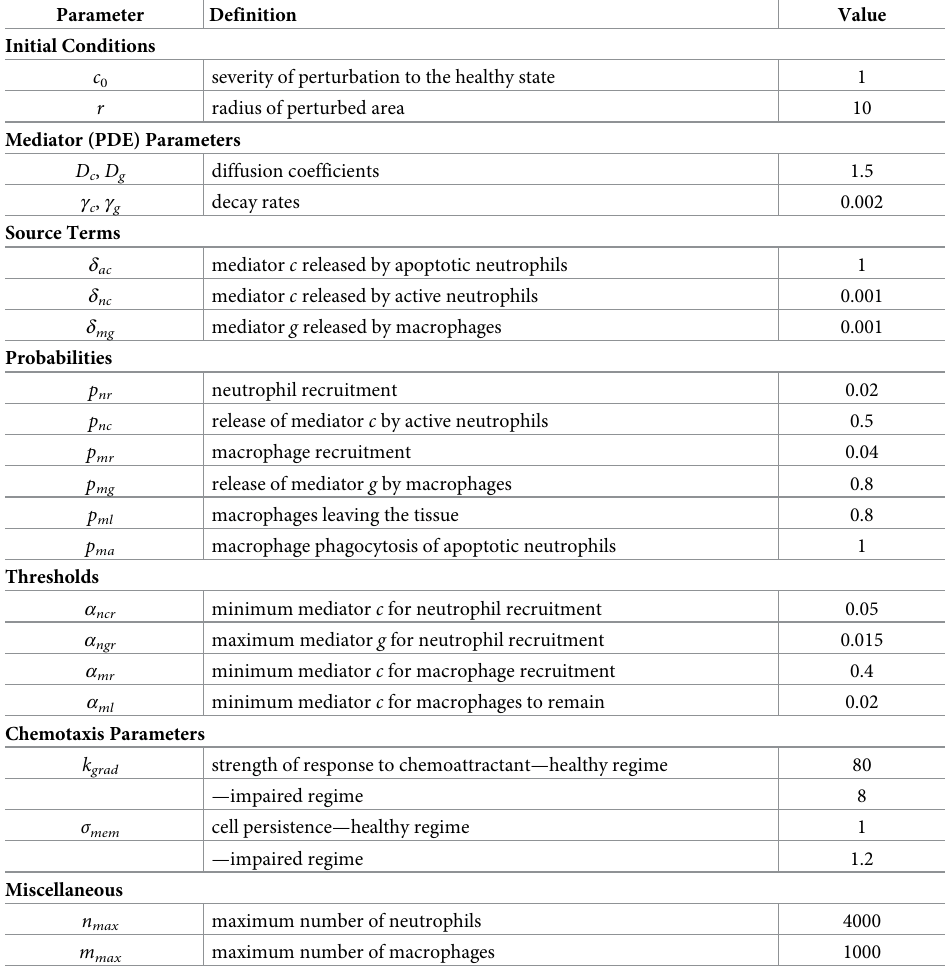
Table 1. Model parameters, together with baseline values used in the simulations below. PDE parameters are inferred from existing literature as described in the text. Chemotaxis parameters are computed via comparison with the experimental data of [10]. The remaining parameters are mostly unavailable in existing literature, and are thus esti- mated based on simulation. The model’s sensitivity to these parameter choices is investigated in more detail in the Results section